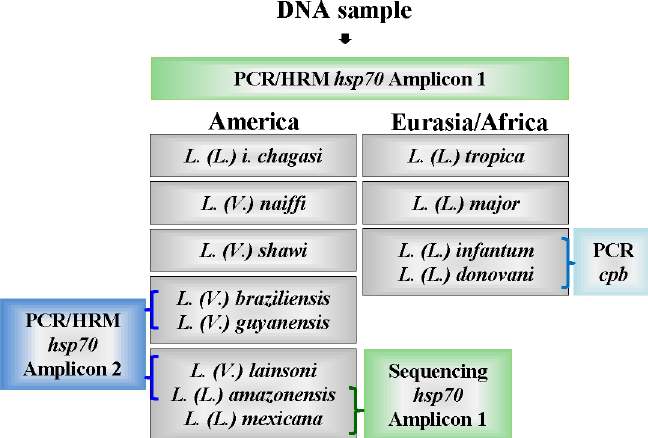
Fig 6. Schematic algorithm representation for Leishmania identification in Brazilian or Eurasian/ African samples. Purified DNA was submitted to hsp70 PCR to produce amplicon 1. The melting analysis of hsp70 amplicon 1 for American samples discriminates L . (L . ) infantum chagasi , L . (V . ) naiffi and L . (V . ) shawi . The grouping of L . (V . ) braziliensis/L . (V . ) guyanensis can be discriminated by producing hsp70 PCR amplicon 2. Amplicon 2 also resolve the grouping L . (L . ) amazonensis/L . (L . ) mexicana/L . (V . ) lainsoni , which is positive for L . (V . ) lainsoni , or by sequencing hsp70 PCR amplicon 1 to discriminate between L . (L . ) amazonensis